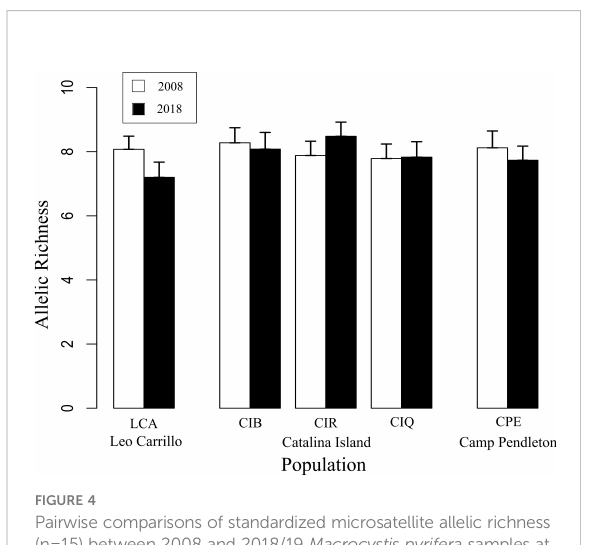
FIGURE 4 Pairwise comparisons of standardized microsatellite allelic richness (n=15) between 2008 and 2018/19 Macrocystis pyrifera samples at each of the three locations sampled in Southern California. No signi fi cant change in allelic richness was found between sampling periods (Wilcoxon: p=